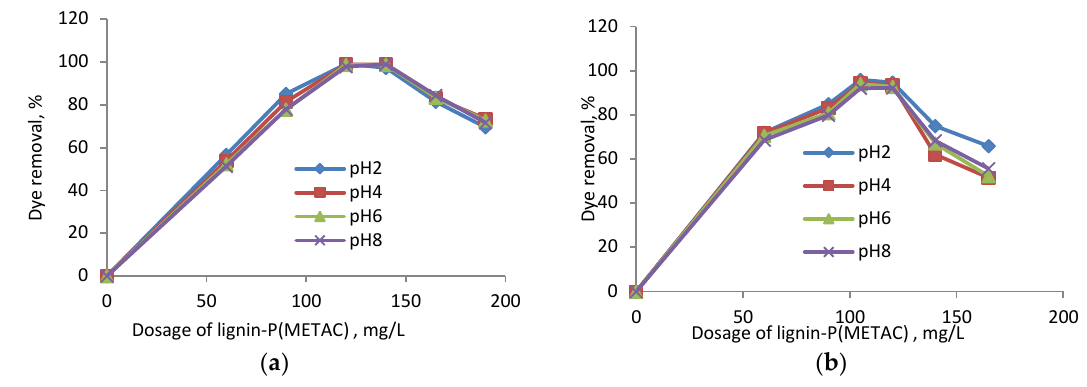
Figure 1. Effect of pH on the dye removal of ( a ) RB5; ( b ) RO16 (from a dye concentration of 100 mg/L) using Sample 4.